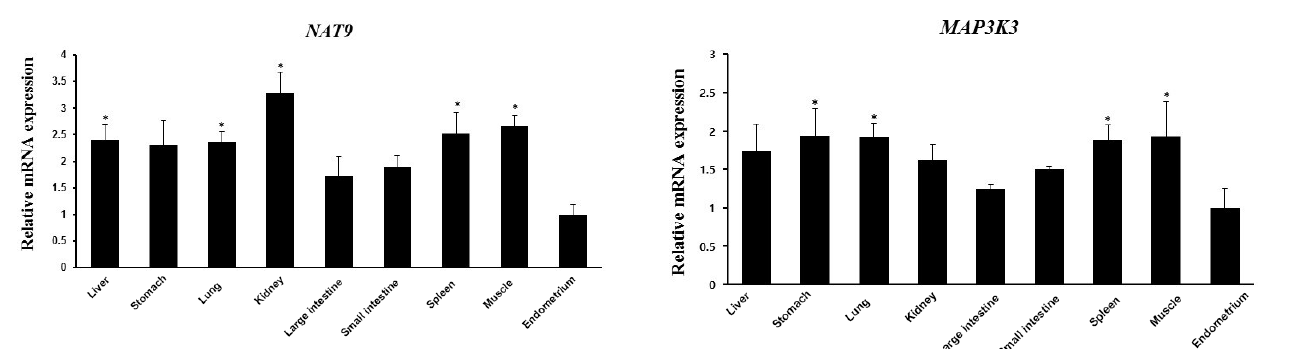
Figure 3. NAT9 mRNA expression in various tissues (liver, stom- ach, lung, kidney, large intestine, small intestine, spleen, muscle, and endometrium) as determined by RT-PCR. Peptidylprolyl iso- merase A (PPIA) was used as an internal control. The fold change in mRNA expression level was calculated by comparing the lowest expression level in the endometrium with that in the other tissues. Data represent mean ± SD. ∗ represents p< 0 . 05.